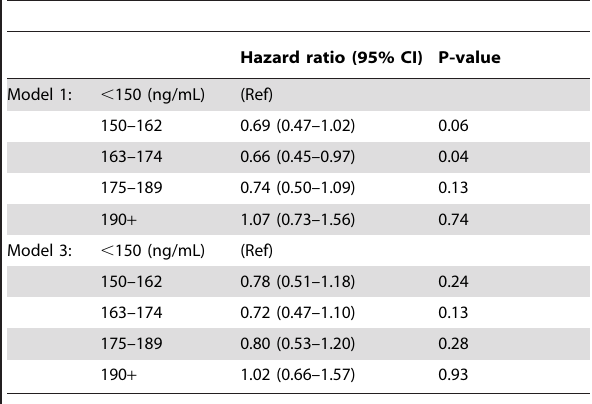
Table 3. The relationship between MMP-2 and incident atrial fibrillation modeled by quintiles, ARIC 1990–2007.